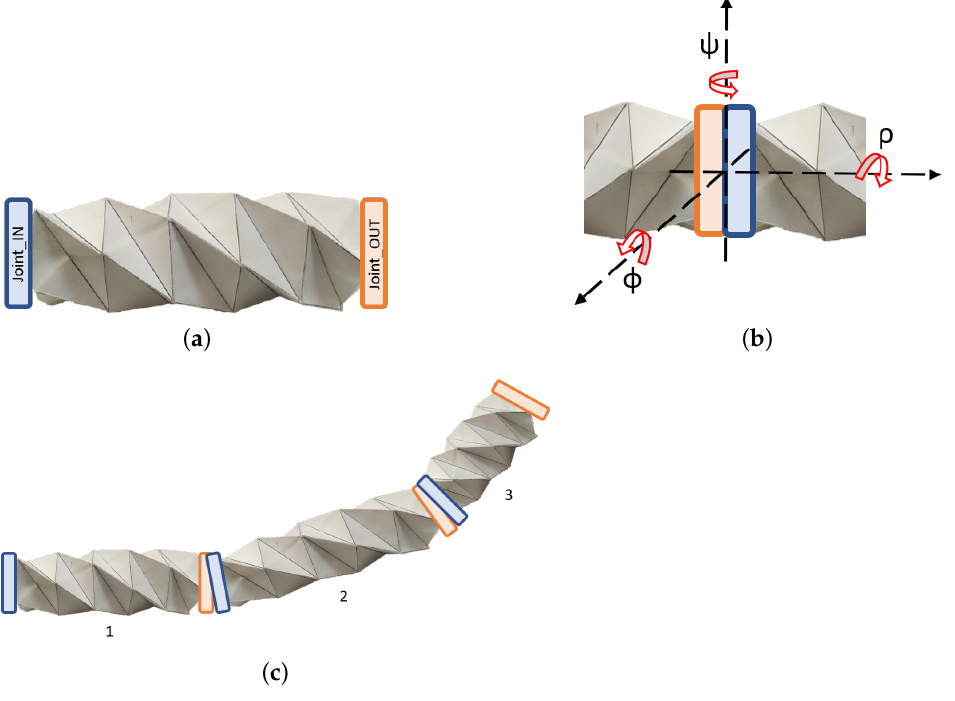
Figure 3. Connection of links. ( a ) Five-sections link with joints. ( b ) Joint between links. ( c ) Joined and reconfigurable